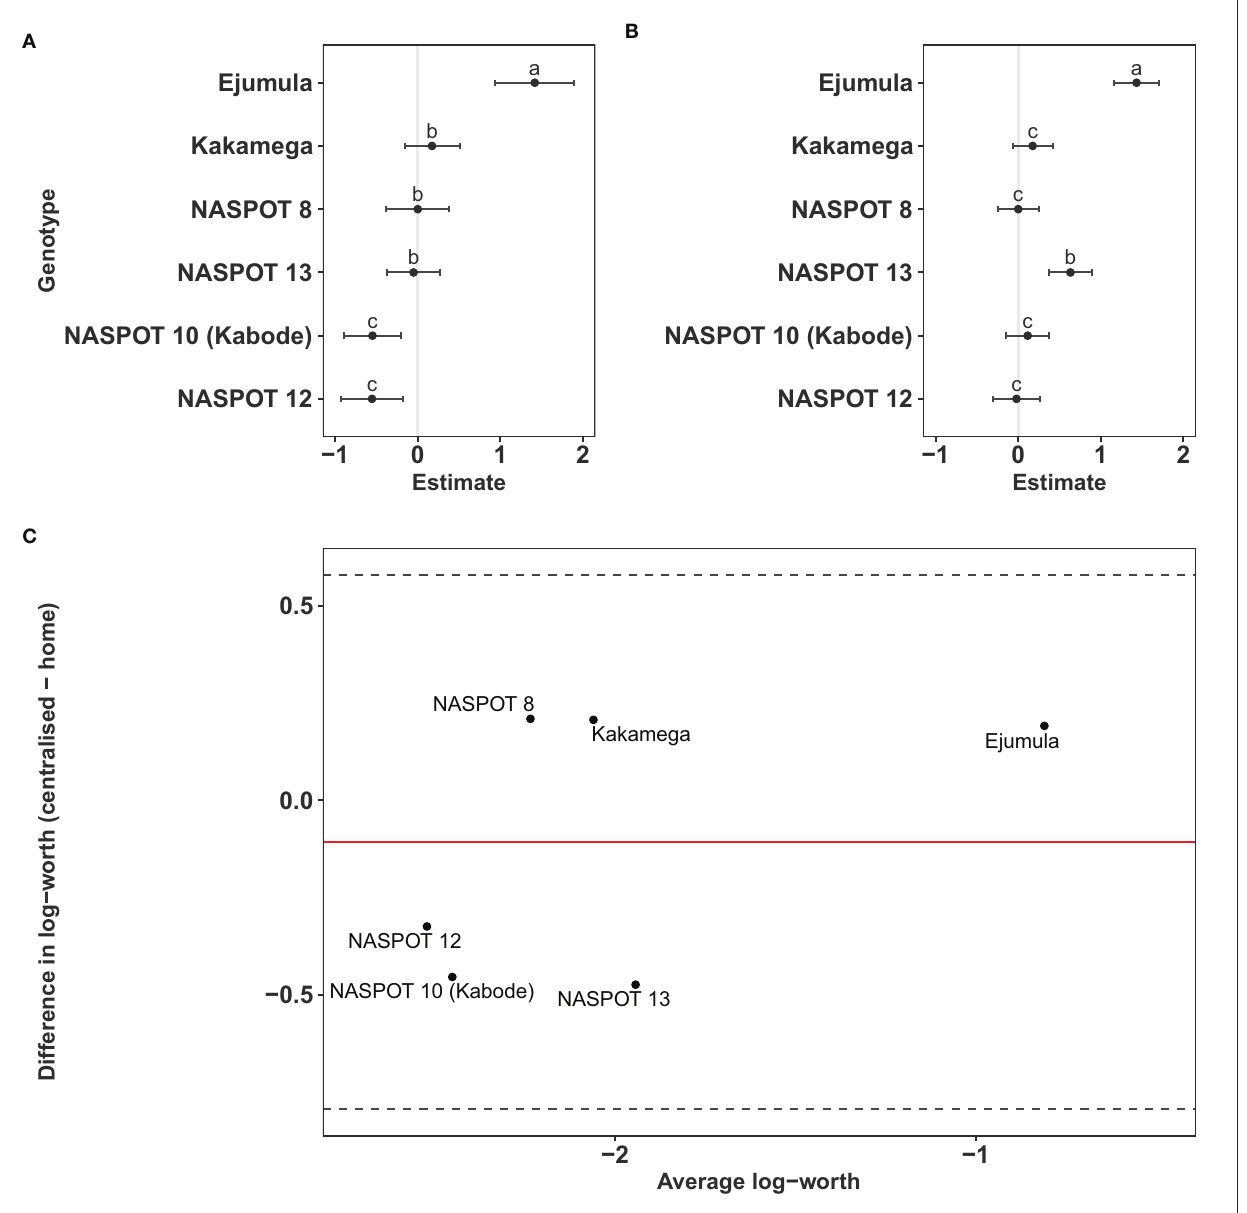
FIGURE 5 | Plackett-Luce Model estimates (log-worth parameters) from tested genotypes in Uganda. Different letters indicate significant differences at p < 0.05. (A) Log-worth parameters from centralized tasting. (B) Log-worth parameters from home tasting. (C) Difference between log-worth parameters in centralized and home tasting in Uganda. The genotype “NASPOT 8” is set as a reference (log-worth arbitrarily set to zero). In (C) , solid red line represents the mean of difference in log-worth (centralized–home), upper dashed lines represent the mean + 2SD (standard deviation), bottom dashed line represent the mean −